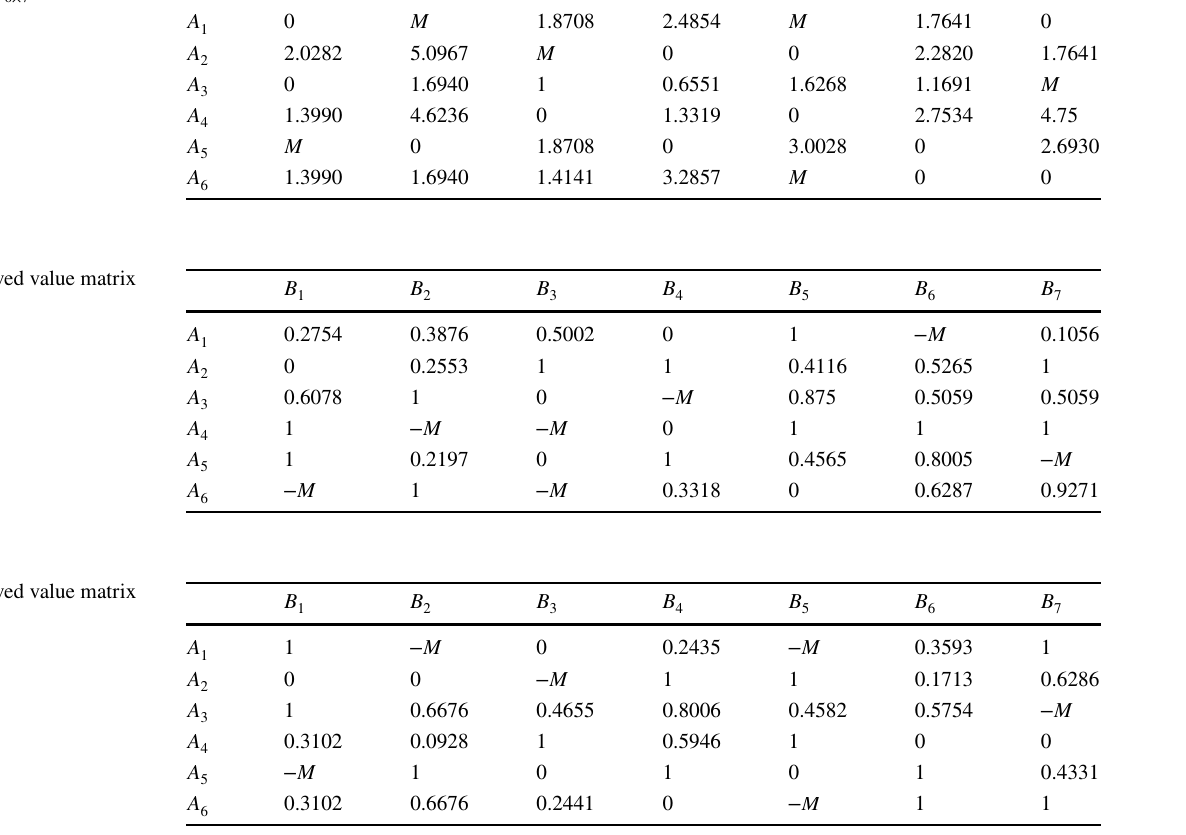
Table 7 Perceived difference matrix D = ( d ij ) 6 × 7